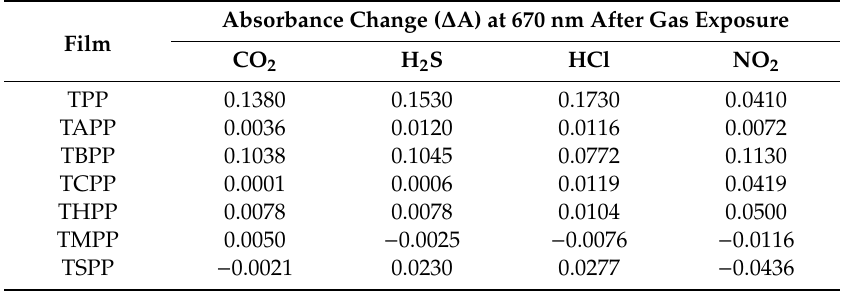
Table 4. Absorbance change at 670 nm of each porphyrin with gas